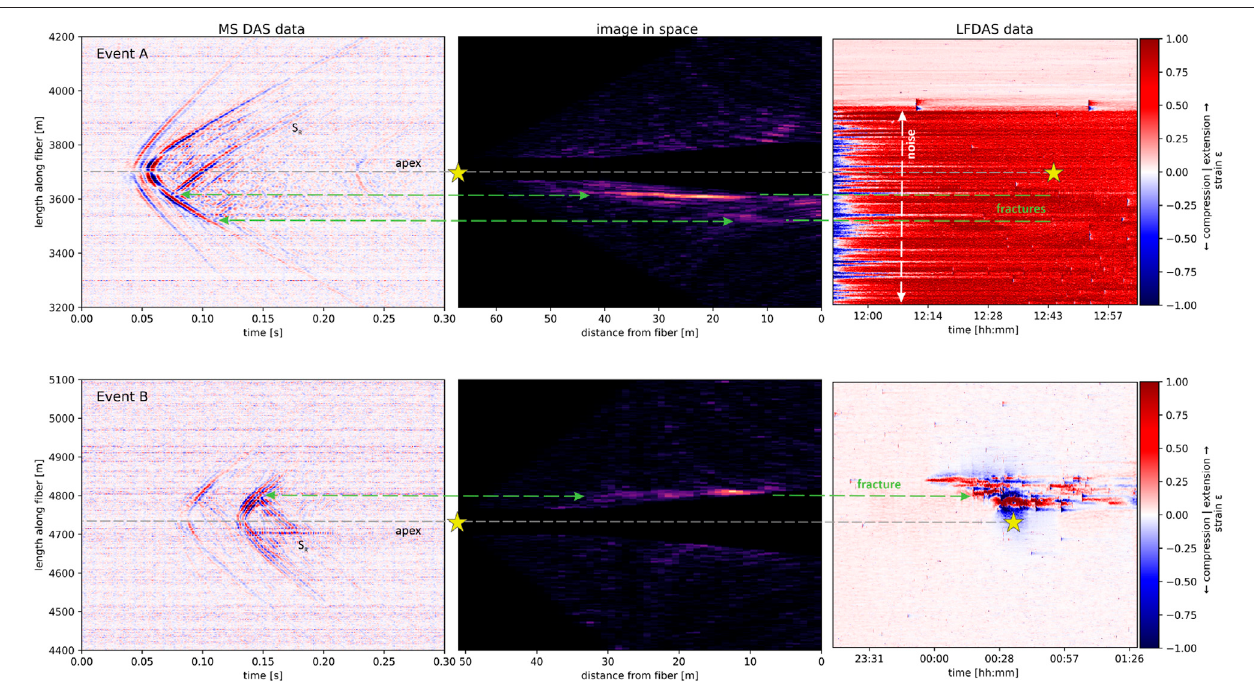
FIGURE 3 | Input DAS data, re fl ector images, and LFDAS data for two example events. The green dashed-line arrows highlight the positions of re fl ectors in the images. The yellow stars represent the location and origin time (only in the LFDAS data) of microseismic events.